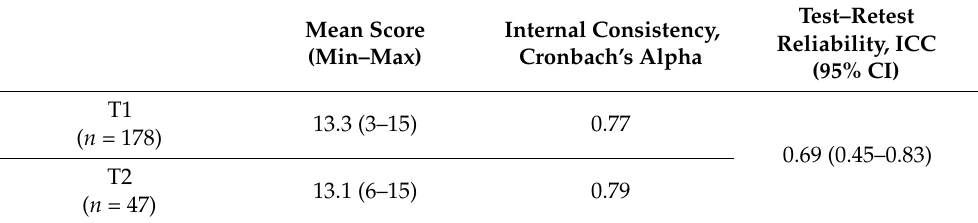
Table 4. Mean score and reliability of the three health literacy screening questions.